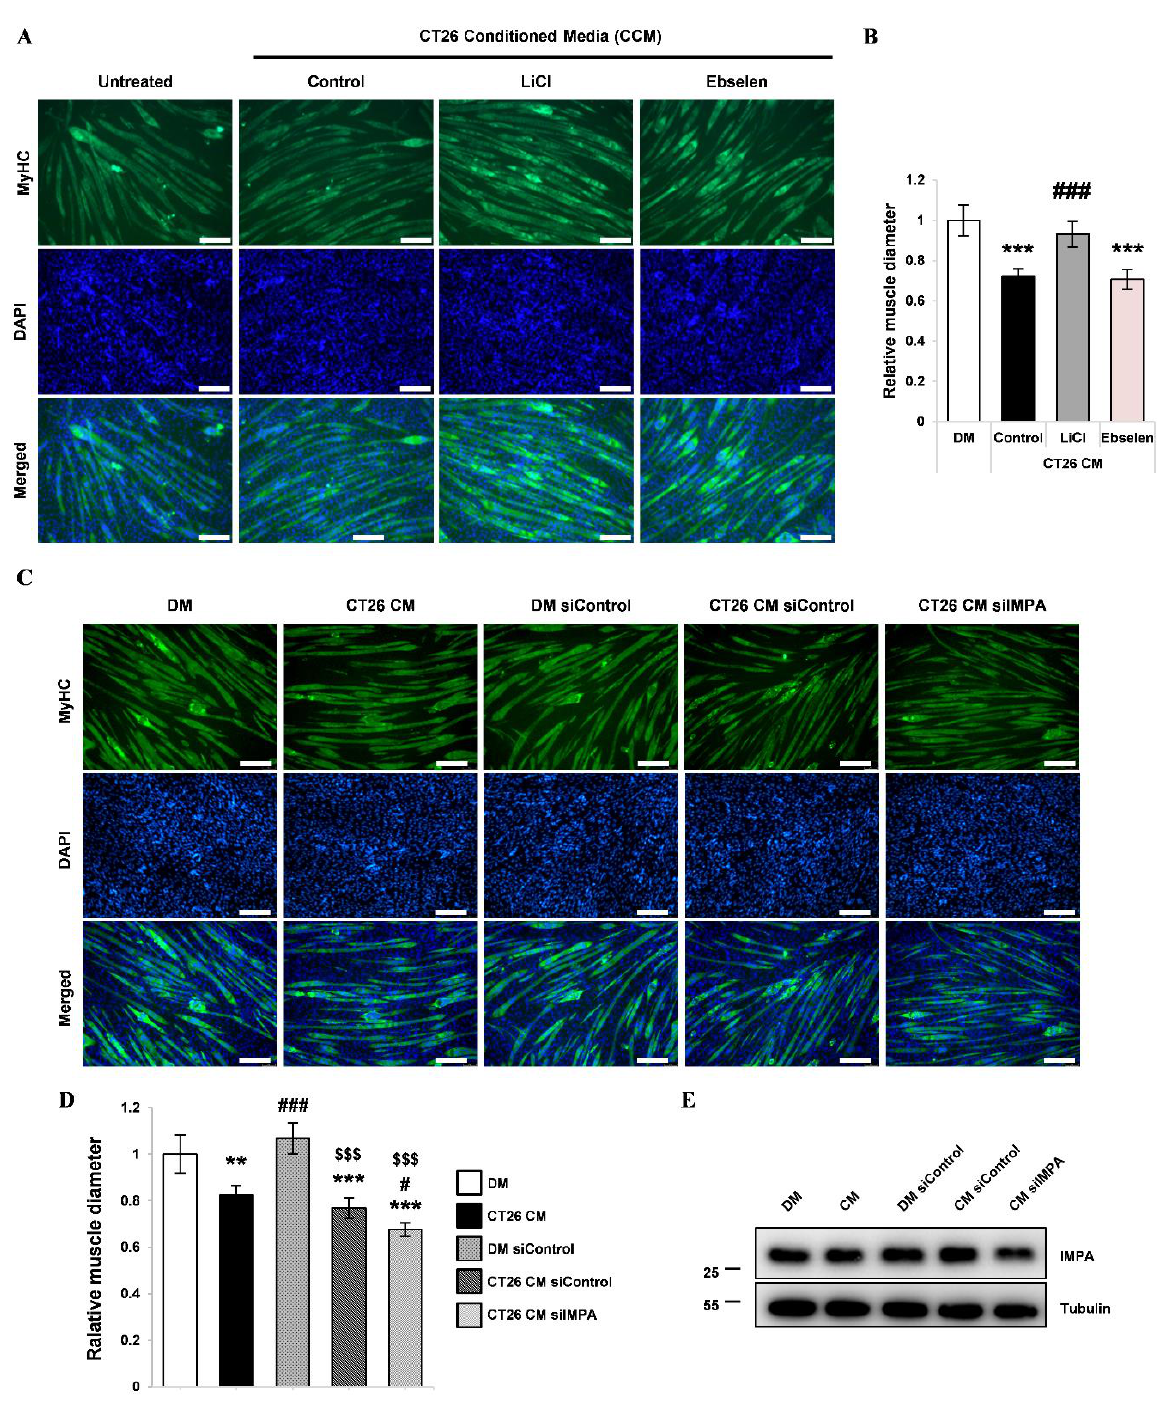
Figure 4. Effect of the lithium mimetic and IMPase inhibitor, ebselen, on CCM-induced wasting in C2C12 myotubes ( A ) Immunofluorescence staining for MyHC after 72 h of culture in (1) DM, (2) CCM, (3) CCM and 5 mM LiCl, and (4) CCM and 10 µM ebselen. DAPI staining was used to visualize cell nuclei. Scale bar = 100 µm. (n = 3). ( B ) Quantification of